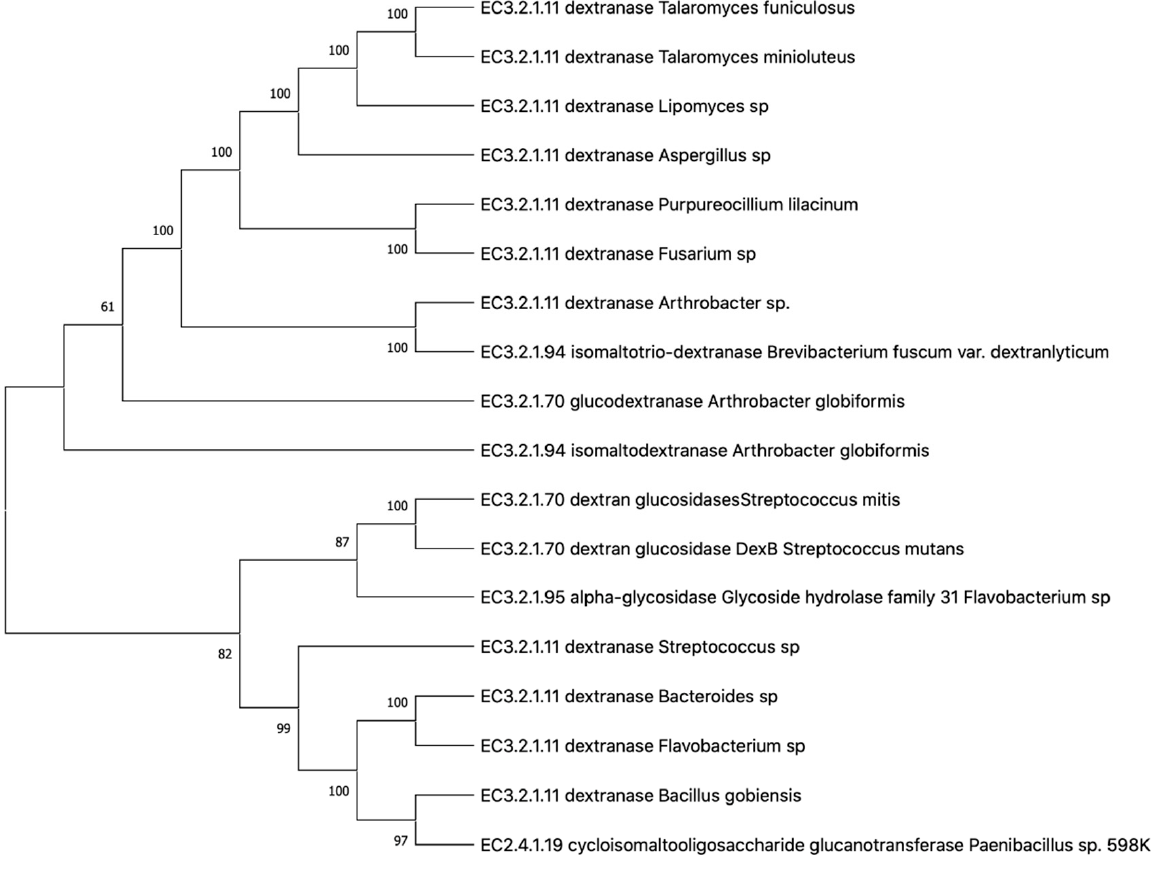
Figure 2. Phylogenetic tree of dextranases from various sources. Phylogenetic tree performed with Neighbor-Joining method by MEGA X of various sources of dextranases, including those identified from bacteria, Fungi etc. The tree was drawn to scale, with branch lengths in the same units as those of the evolutionary distances used to infer the phylogenetic tree. The percentage of replicate trees in which the associated taxa clustered together in the bootstrap test (10,000 replicates) are shown next to the branches.